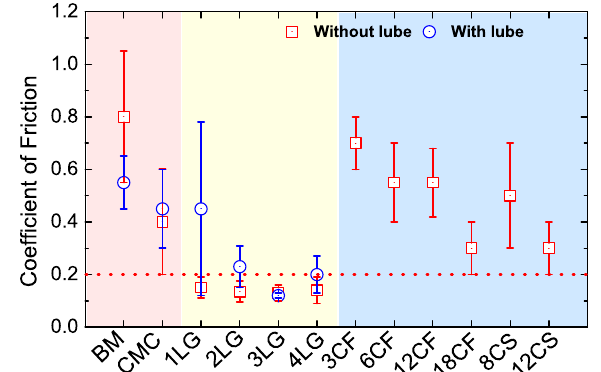
Fig. 4 Comparison of measured coef fi cients of friction. Average COF from measurements in Fig. 3, with and without lubricant, for 1 – 4LG and all COC reference samples. The red shaded region highlights the bare media and media with a commercial overcoat, the yellow region highlights media with graphene overcoat, and the blue region highlights media with FCVA-ta-C. The horizontal red dashed line is a reference at COF = 0.2. The error bars indicate the spread around the average COF.